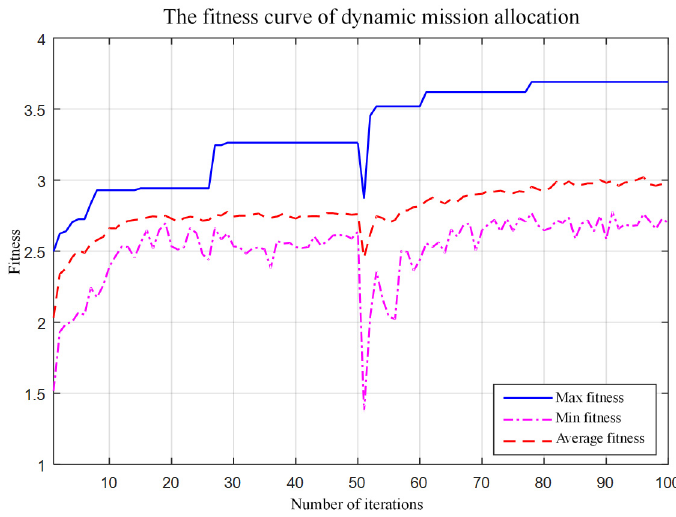
Figure 8. The change curve of fitness before and after new emergency tasks.